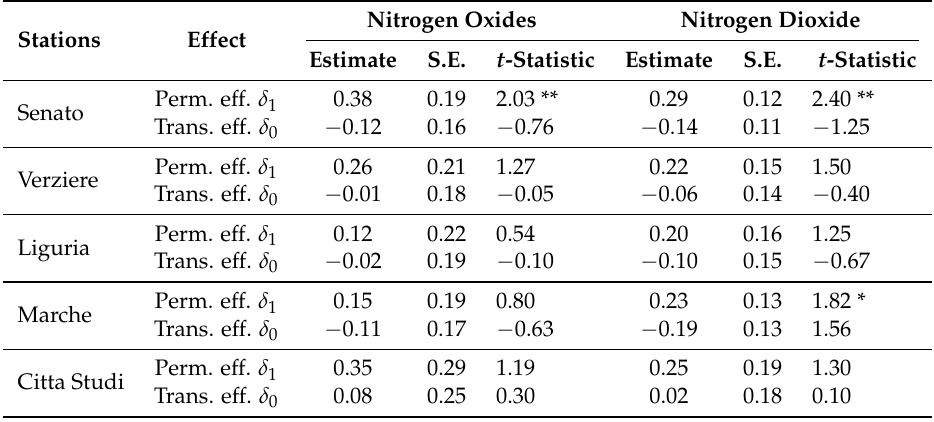
Table 6. Estimated permanent and transitory effects in log scale on NO x and NO 2 for each station. Nitrogen Oxides Nitrogen Dioxide Stations Effect Estimate S.E. t -Statistic